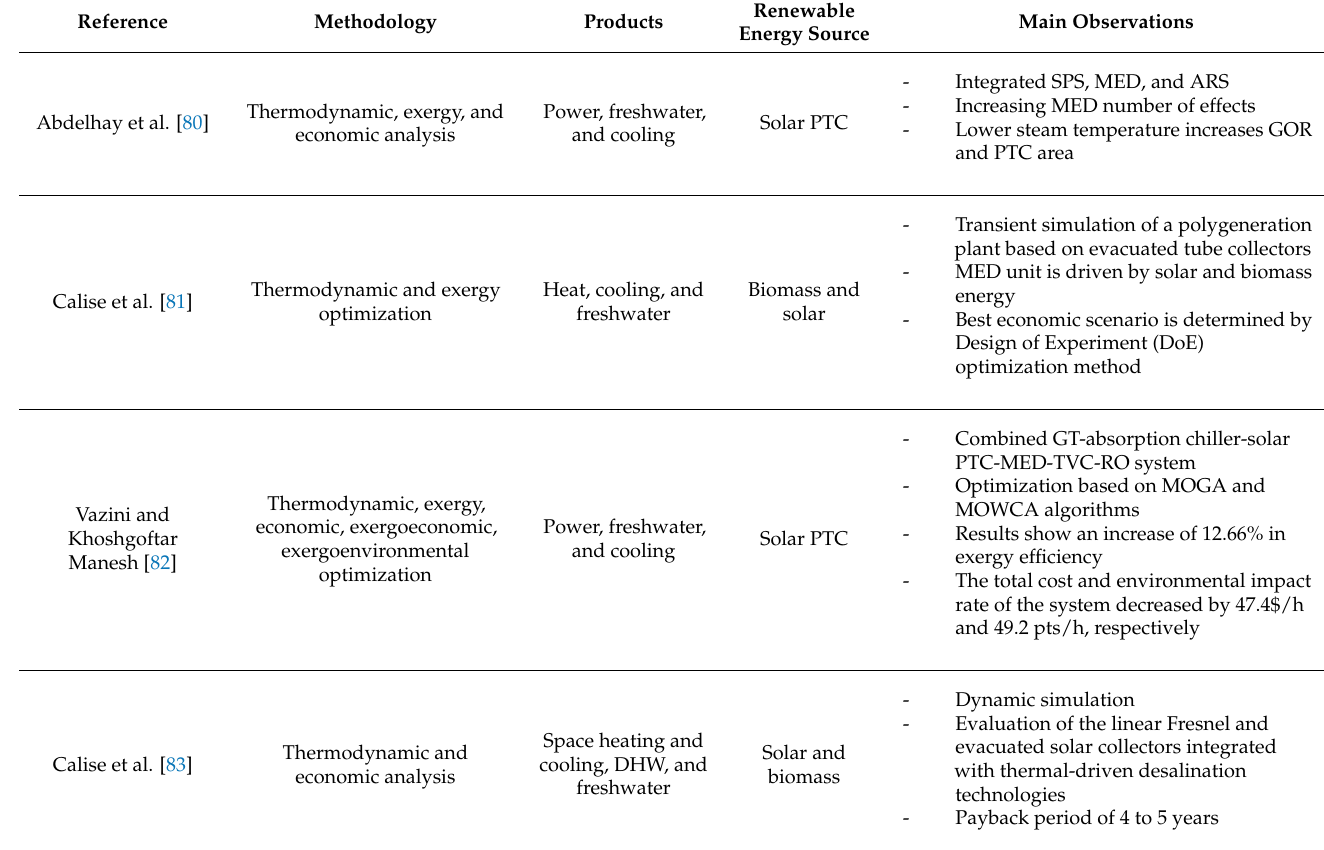
Table 2. Summary of topical research on integrated renewable energy-driven polygeneration and MED desalination systems.